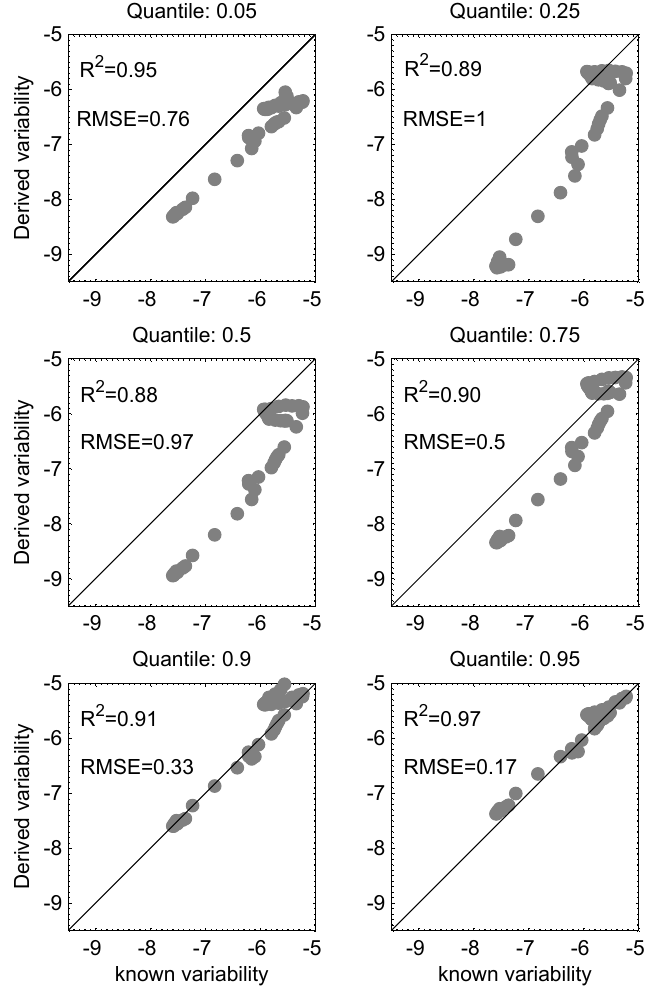
Figure 2. Known versus derived variability corresponding to predefined quantiles on a log-scale of radiometric data. The 1:1 line is also